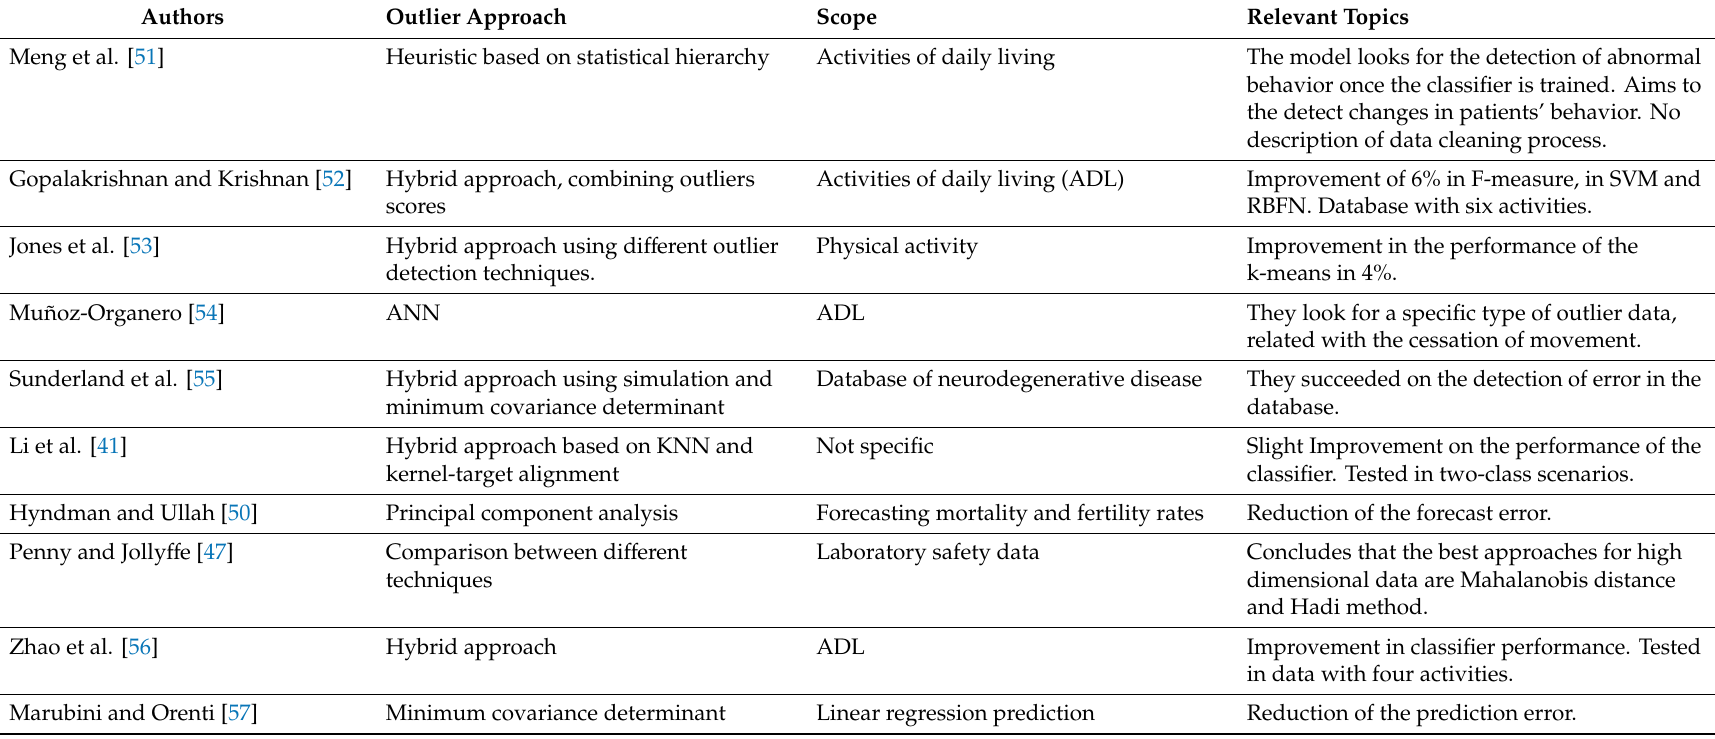
Table 1. Relevant research regarding outlier detection in